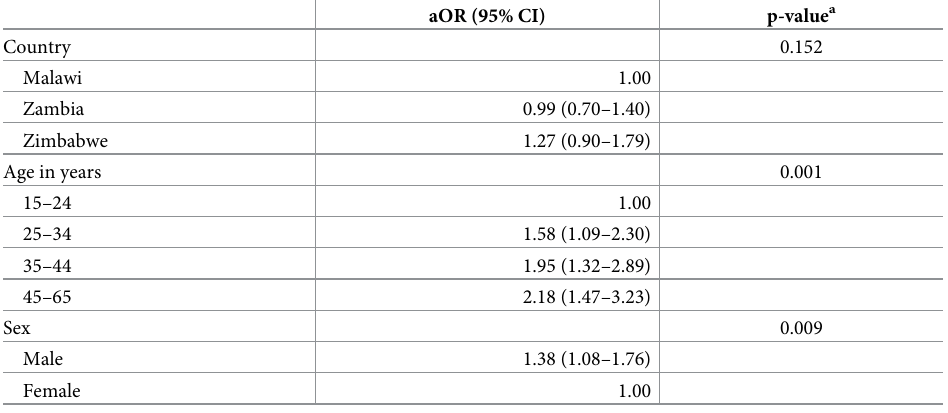
a P-values of categorical variables are for joint test for significance. Analysis adjusted for age, sex, and country. Abbreviations: aOR, adjusted odds ratio; CI, confidence